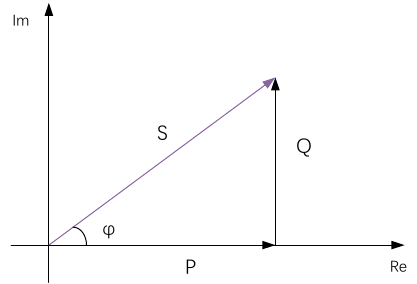
Figure 1. The power triangle in the AC circuit. S is the complex power and the magnitude of S is called apparent power. Active power P is represented as the real axis while reactive power is represented as the imaginary axis of the vector diagram. φ is the angle of difference (in degrees) between current and voltage.